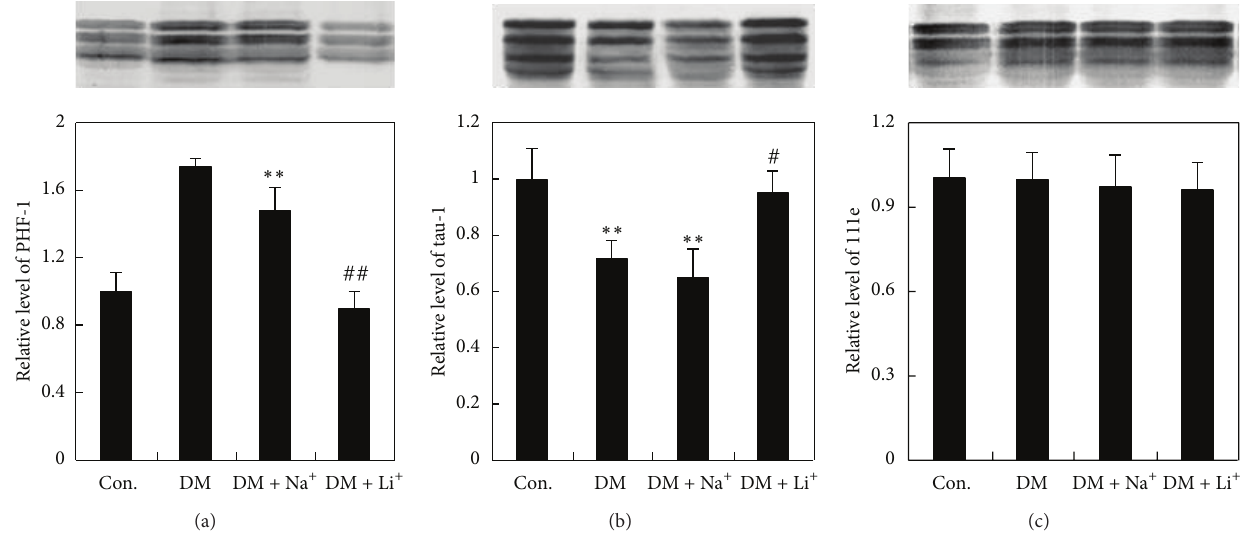
Figure 5: Tau phosphorylation. ∗ 𝑃 < 0.05 and ∗∗ 𝑃 < 0.01 versus control group, # 𝑃 < 0.05 and ## 𝑃 < 0.01 versus DM